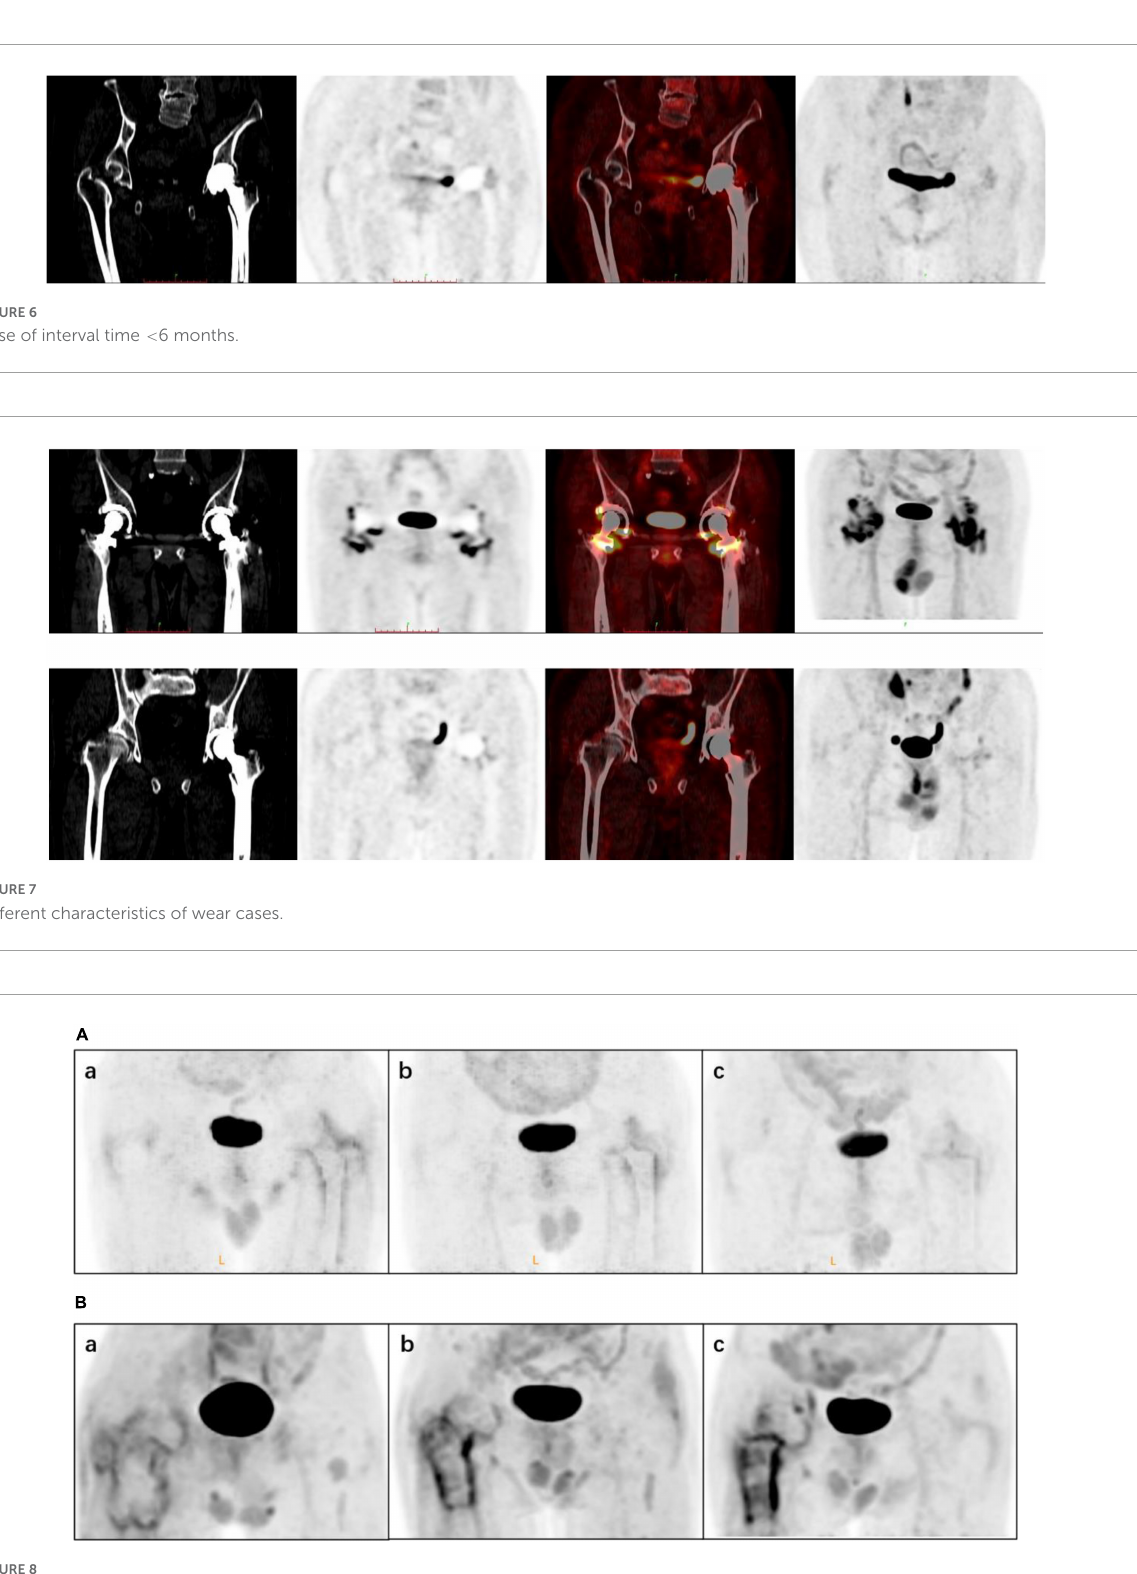
FIGURE8 Two patients had multiple 18 F-fluorodeoxyglucose ( 18 F-FDG) positron emission tomography (PET)/computed tomography (CT) images. Patient (A) underwent total hip arthroplasty (THA) during chemotherapy: (a) 6 months, (b) 18 months and (c) 31 months postoperatively. Patient (B) with a tumor prosthesis underwent 18 F-FDG at (a) 1 month, (b) 5 months and (c) 12 months